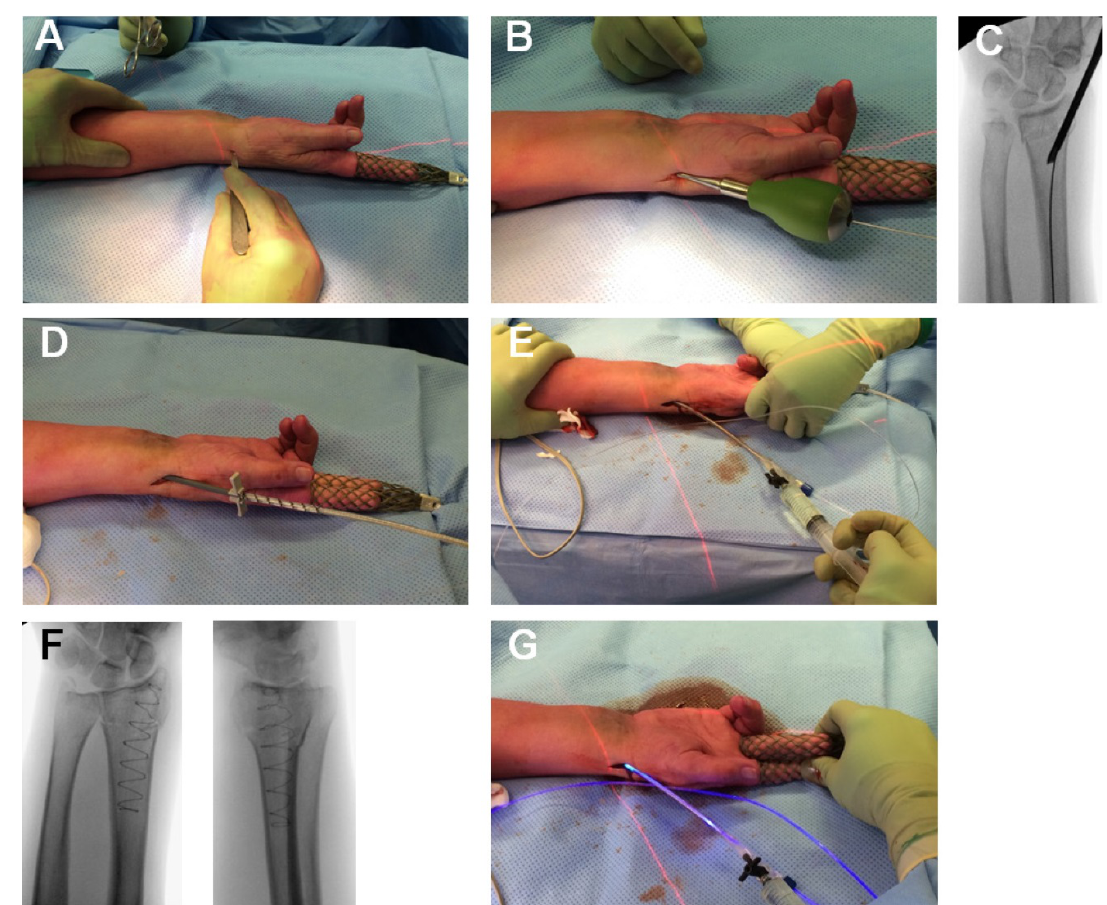
Figure 1. The intramedullary fracture stabilization system used in a distal radius. A: Incision over the radial styloid process. B: Access to the medullary canal. C: Correct position is verified by intra-operative fluoroscopy. D: Flexible balloon catheter is placed intramedullary over the guide-wire spanning the fracture. E: Infusion of liquid monomeric material and expansion of the Dacron balloon conforming to the patient’s unique medullary canal. F: Verification of adequate fracture reduction, correct balloon position, and balloon expansion. G: Polymerization (hardening) of the infused monomer by applying blue